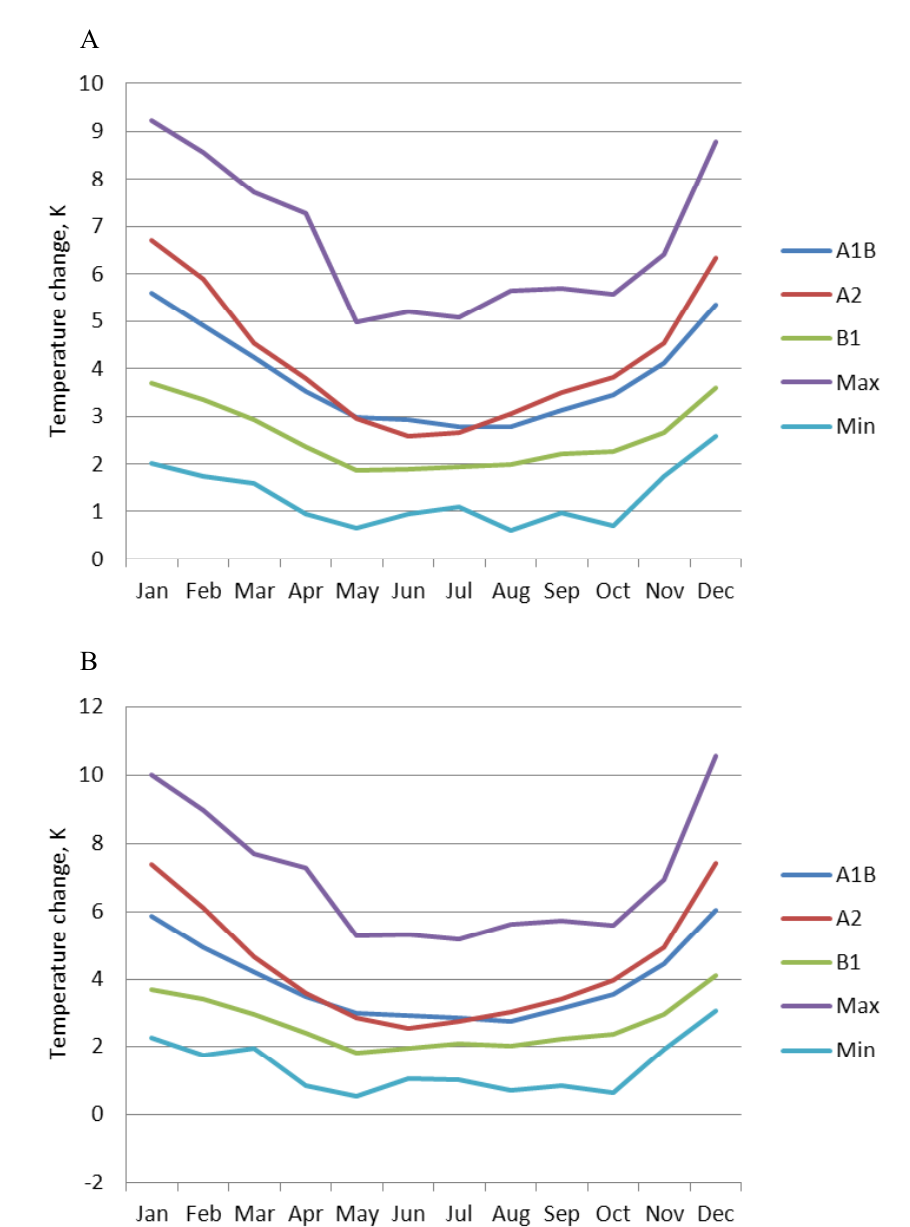
Fig. 4. Multi-model mean annual curves of monthly mean temperature changes for 2070(cid:150)2099 (in comparison with the 1961(cid:150) 1990 baseline period) in western Estonia ( A ) and in eastern Estonia ( B ) using three SRES emission scenarios and 12 selected GCM outputs together with the absolute maximum and minimum estimates of these